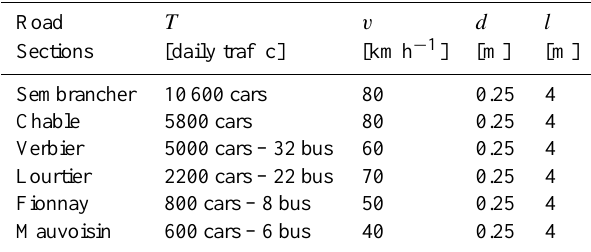
Table 3. Parameters for risk calculation along the different studied road sections (according to CarPostal, 2010, SRCE, 2009 and local road regulations). These road sections are mapped in Fig.